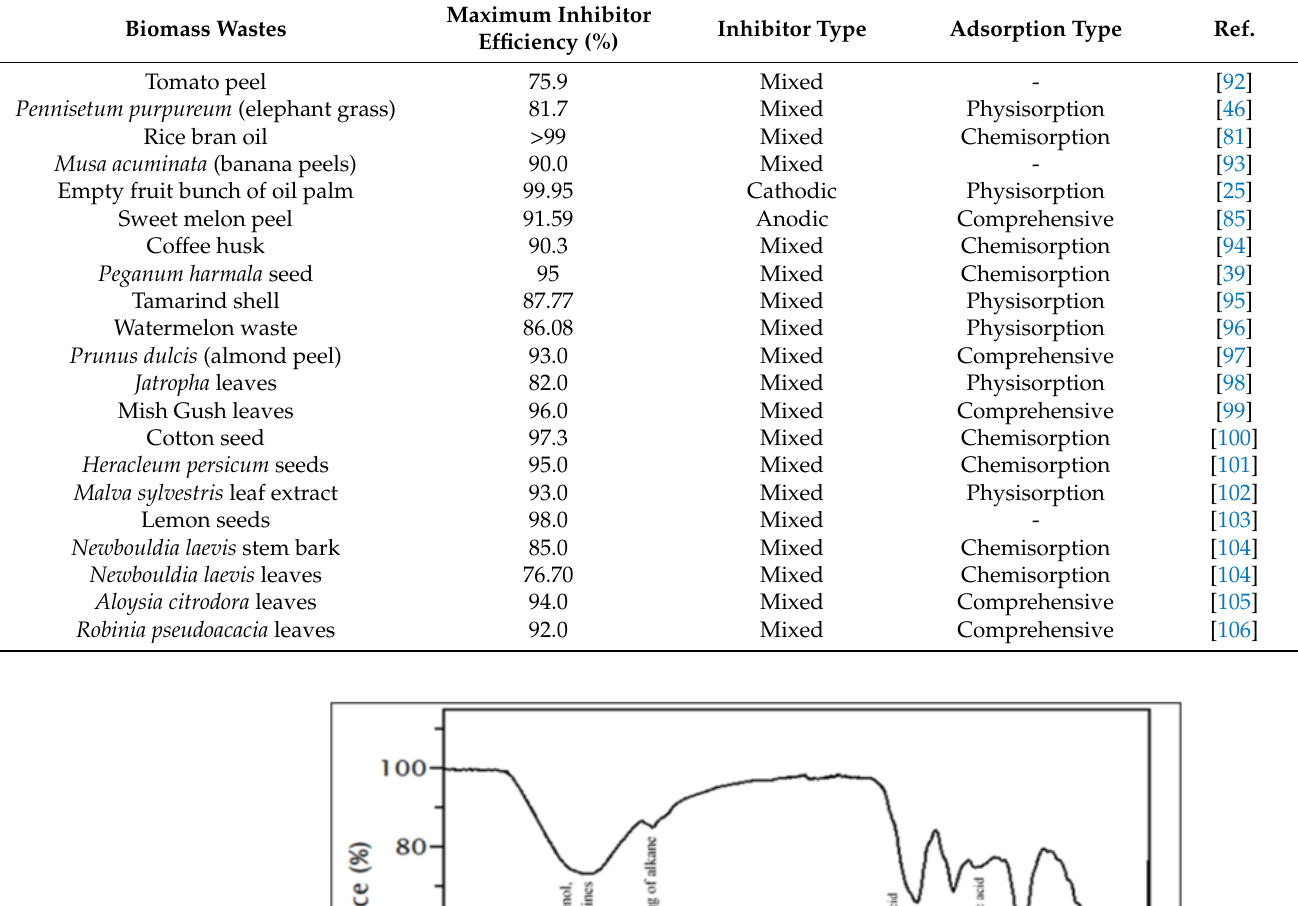
Table 4. Past research concerning biomass waste-based organic corrosion inhibitors.